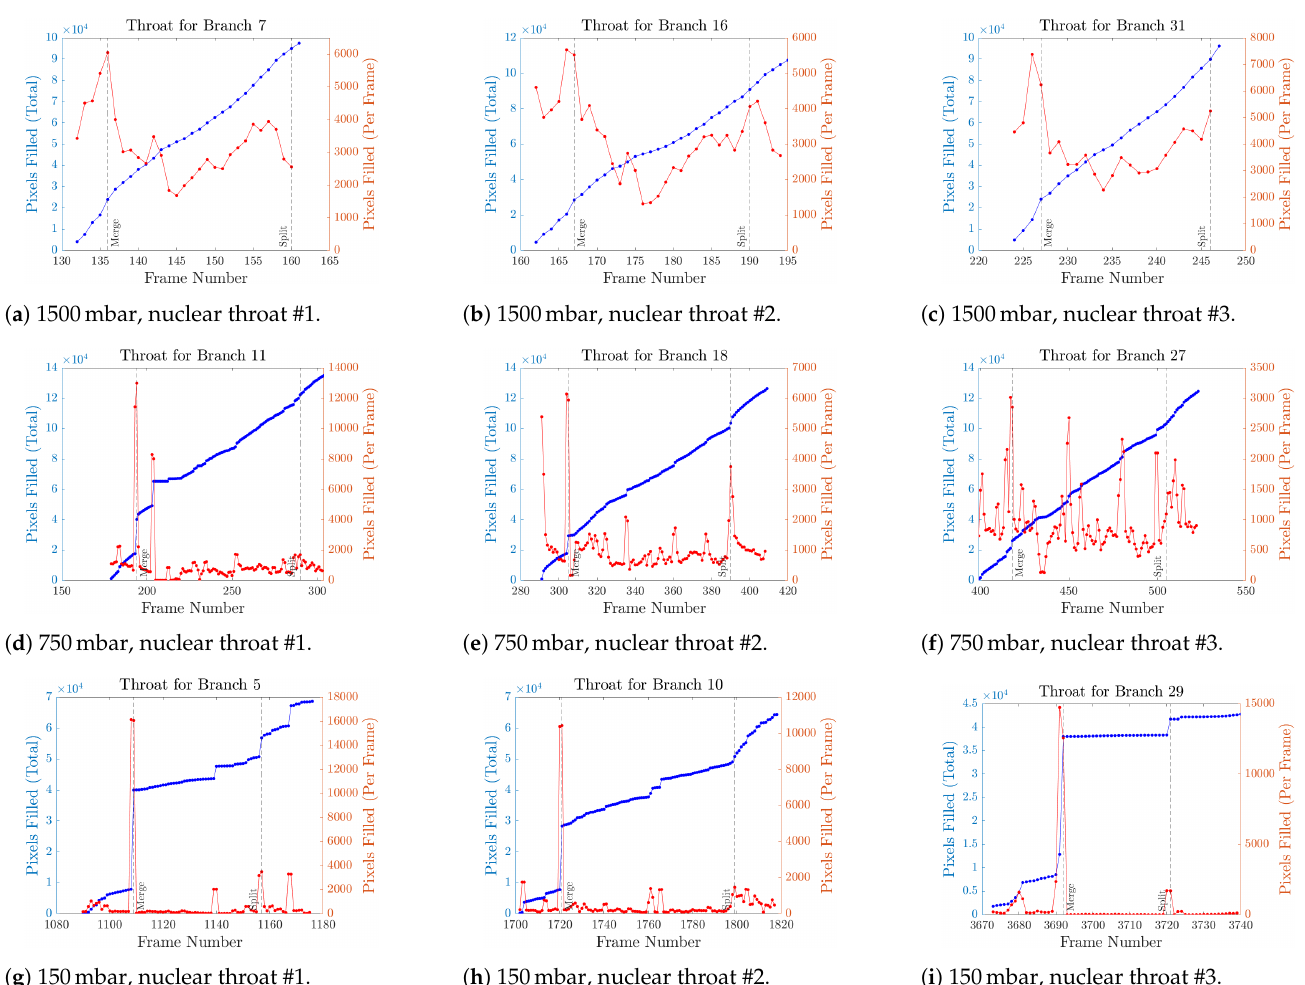
Figure 8. Plots of number of pixels filled versus the frame number filled within three featured throats for every experiment as calculated from recordings (each left axis, blue line), together with the filling speed (each right axis, red